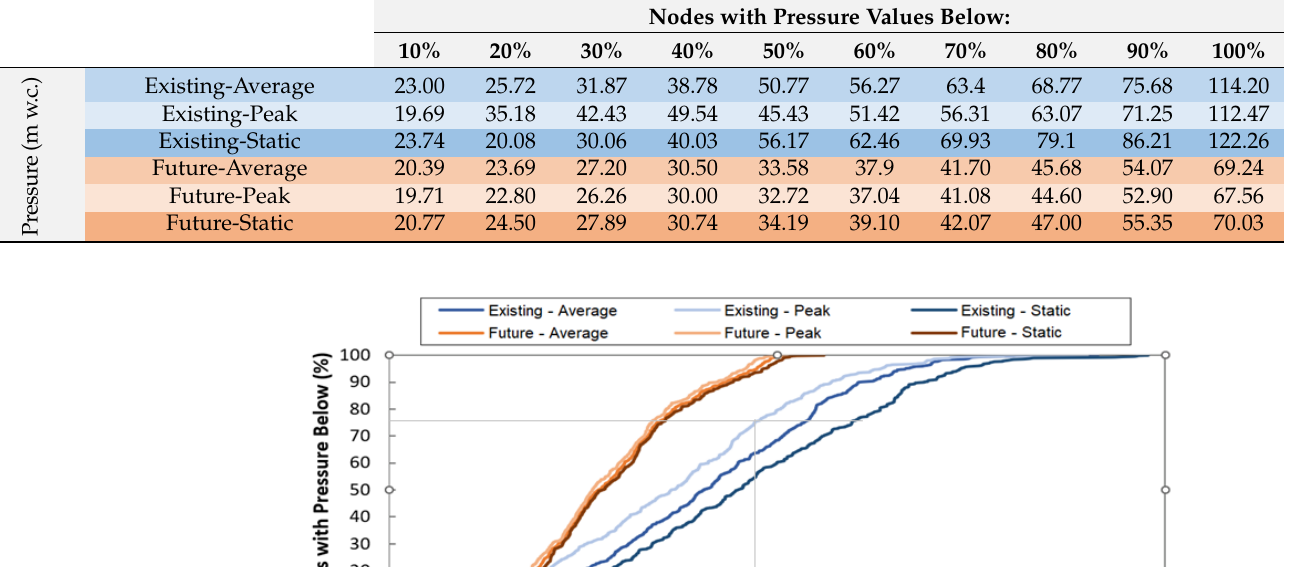
Table 6. Pressure in the node junctions from the DT model results.